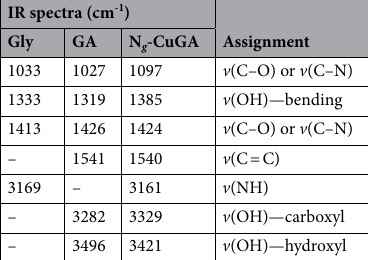
IR spectra (cm -1